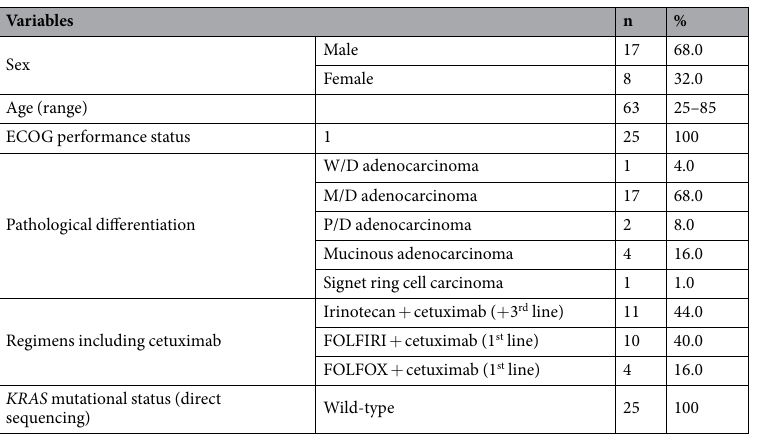
Table 1. Clinicopathological characteristics of all enrolled patients (n = 25). * W/D: well differentiated; M/D: moderately differentiated; P/D: poorly